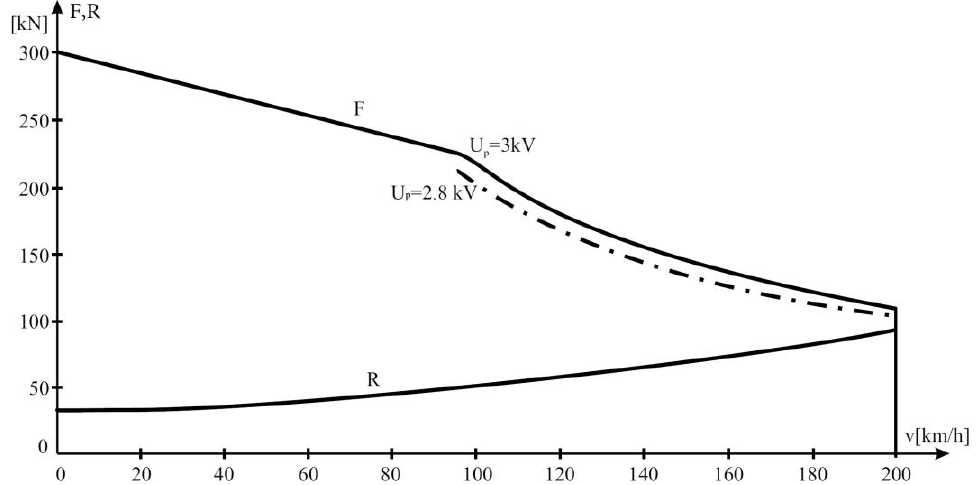
Figure 6. Traction effort F[kN] and resistance R[kN] as a function of speed v and voltage U p for BoBo 6 MW locomotive with 10 passenger coaches (exemplary characteristic assumed by the authors for simulations). Source: Own